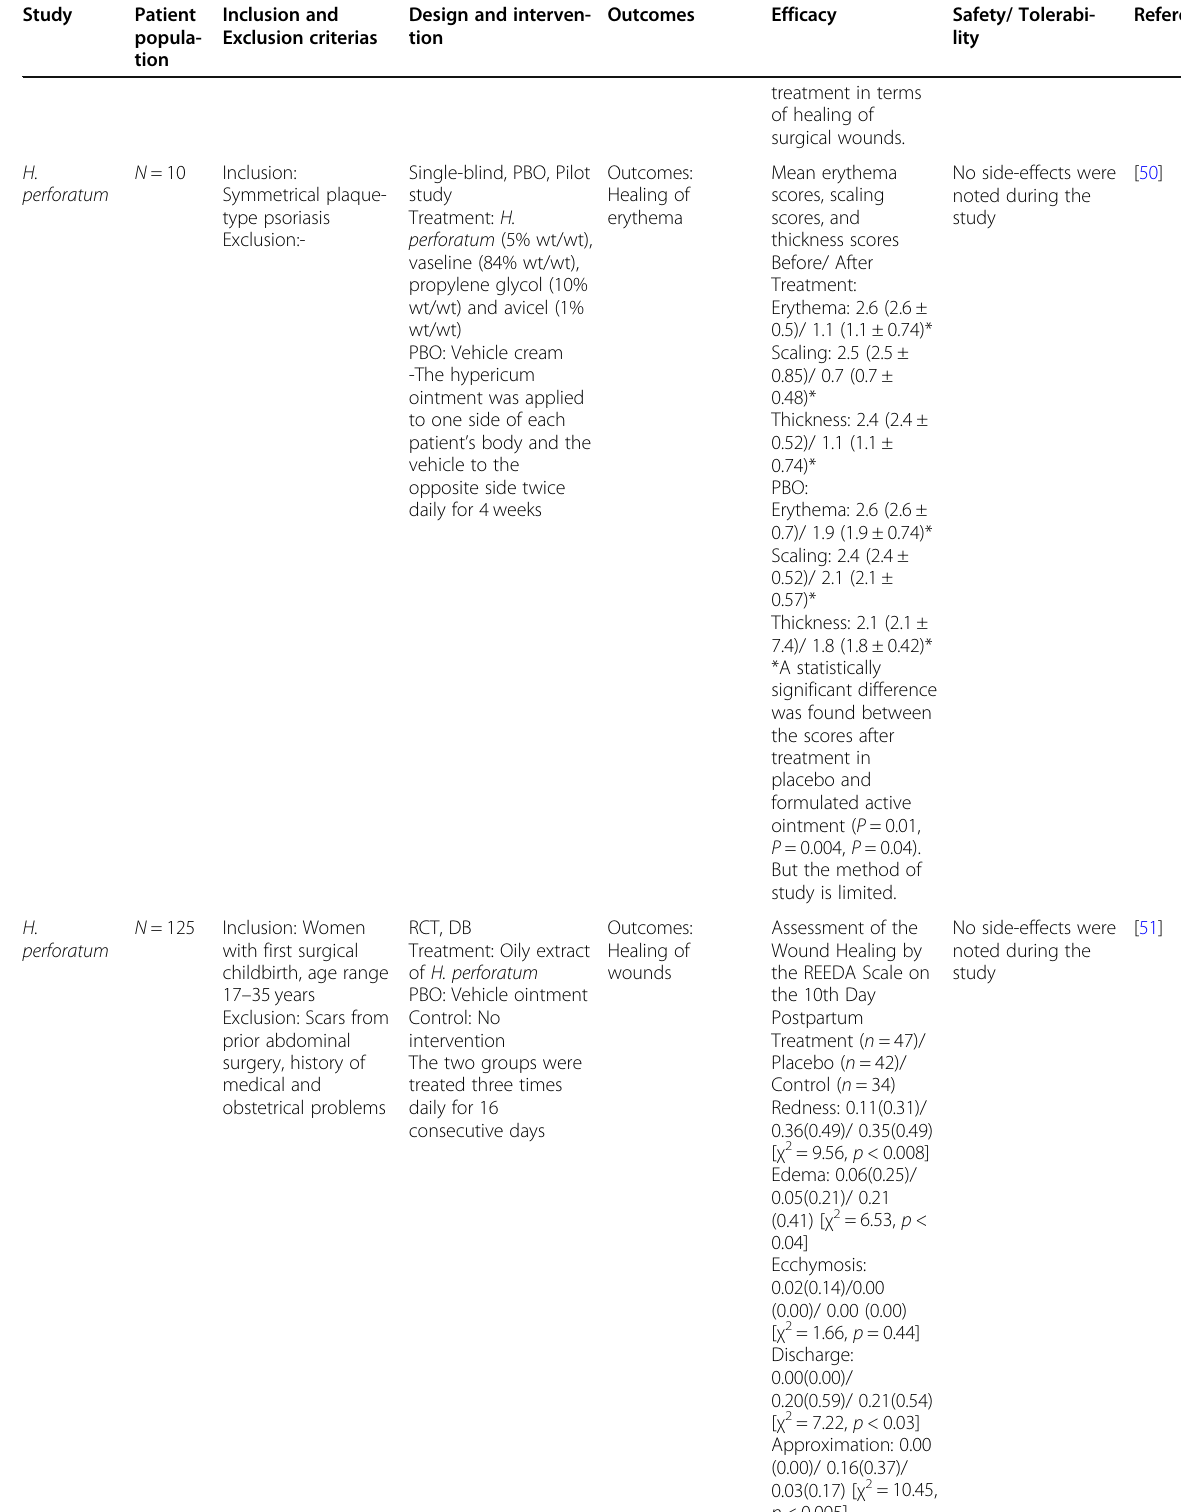
Table 4 Clinical trials of the traditional plants used for skin problems in Turkey (Continued) Study Patient popula-